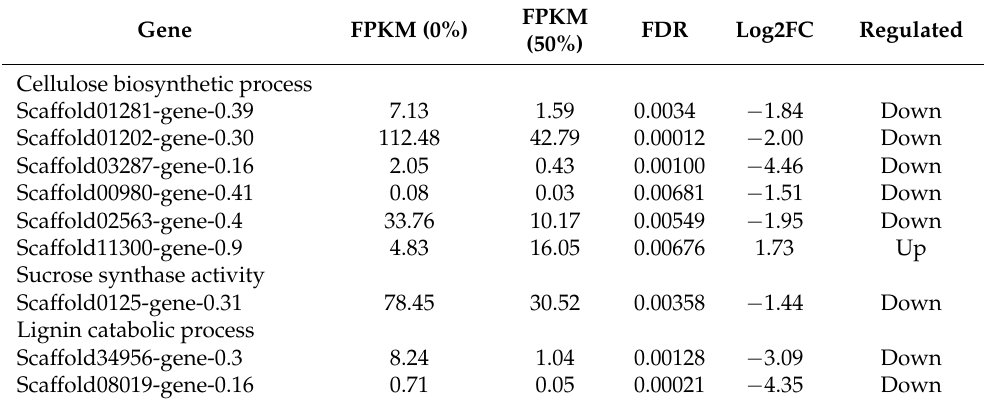
Table 3. Genes involved in cellulose and lignin